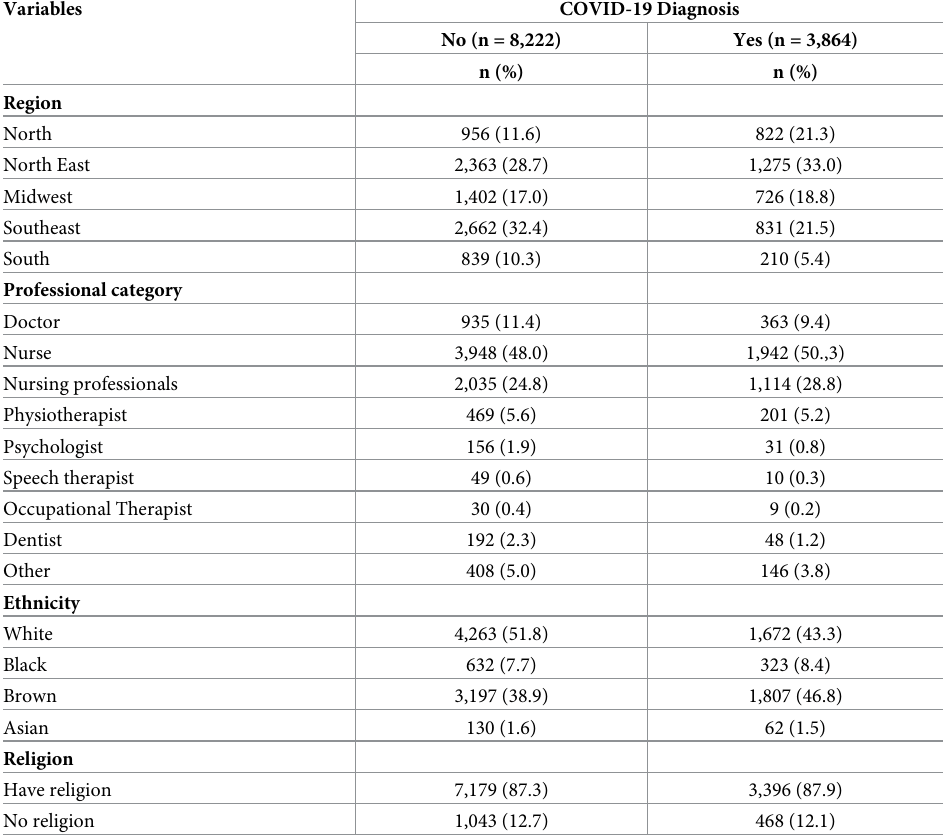
Table 1. Sociodemographic characteristics of Brazilian health professionals according to COVID-19 diagnosis, Brazil, 2020 (N =